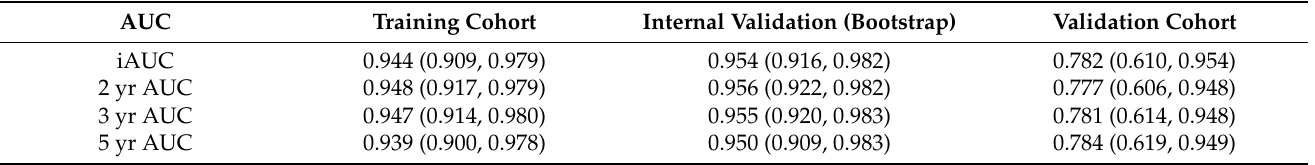
Table 3. Time-dependent AUC of the selected risk prediction model in the training cohort, internal validation using the bootstrap method, and external validation.